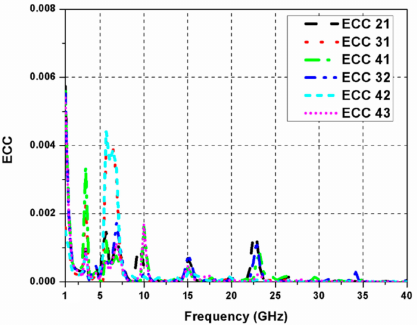
Figure 11. Envelope correlation coe ffi cient (ECC) of the proposed quad-port SWB MIMO